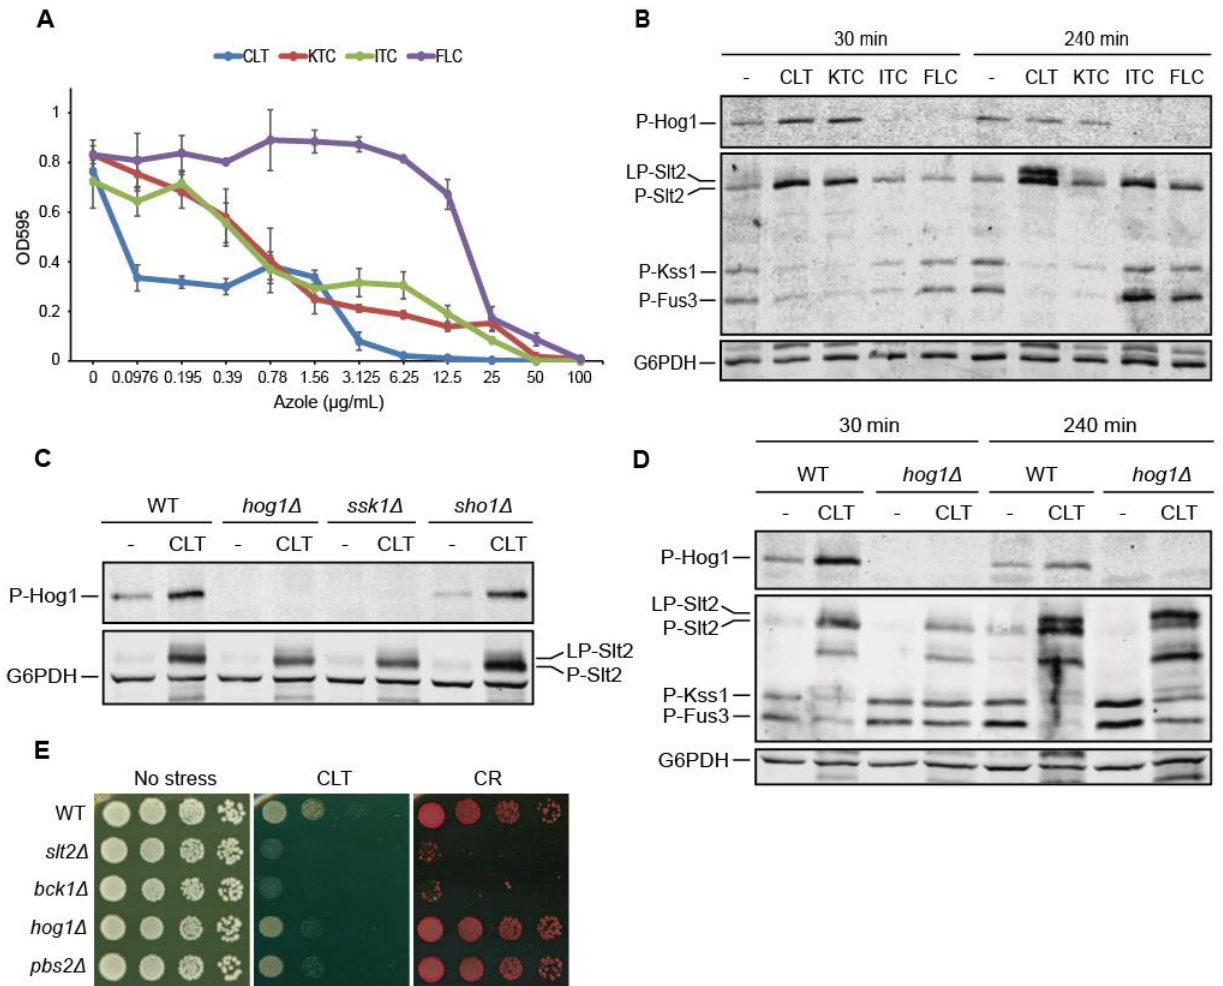
Figure 1. Impact of azole treatment on S. cerevisiae MAPK signaling. ( A ) Multi-well-plate sensitivity assay of the BY4741 strain for the indicated concentrations of clotrimazole (CLT), ketoconazole (KTC), itraconazole (ITC), and fluconazole (FLC). Cells were cultured at 30 °C for 24 h and the optical density at 595 nm (OD 595 ) was measured. Data are presented as the mean of three independent experiments. Error bars indicate standard deviation. ( B ) Western blotting analysis of extracts of BY4741 cells treated with 50 µg/mL of CLT; 400 µg/mL of KTC, ITC, and FLC; or without any azole (-) for the indicated times at 24 °C. Dually phosphorylated Hog1 was detected with anti-phospho-p38; dually phosphorylated Slt2, Kss1, and Fus3 were detected with anti-phospho-p44/42; and G6PDH, encoded by the gene ZWF1 (as the loading control), with anti-G6PDH. ( C , D ) Western blotting analysis of cell extracts of BY4741 (WT) and the indicated isogenic mutant strains. Cells were cultured without (-) or with 50 µg/mL of CLT for 30 min ( C ) or 30 and 240 min ( D ) at 24 °C. Dually phosphorylated MAPKs and G6PDH were detected as described in ( B ). Representative blots from three independent experiments are shown. ( E ) Drop dilution growth assay of BY4741 (WT) and the indicated isogenic mutant strains. Ten-fold serial dilutions of cell suspensions were spotted onto YPD plates in the absence (no stress) or presence of 1 µg/mL of CLT or 30 µg/mL of Congo red (CR) and incubated at 30 °C for 72 h. A representative assay from three independent experiments is shown.